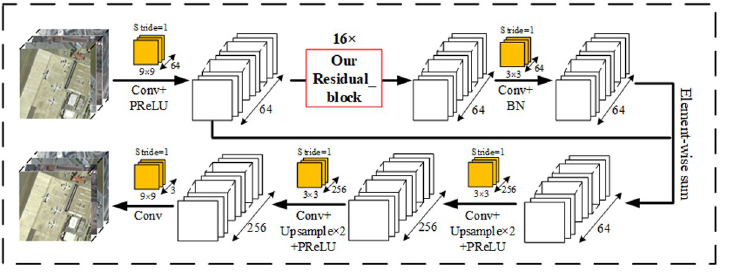
Fig 2. Generator network structure. We replace the original residual block with the new residual block (16 × ) and keep the rest unchanged.